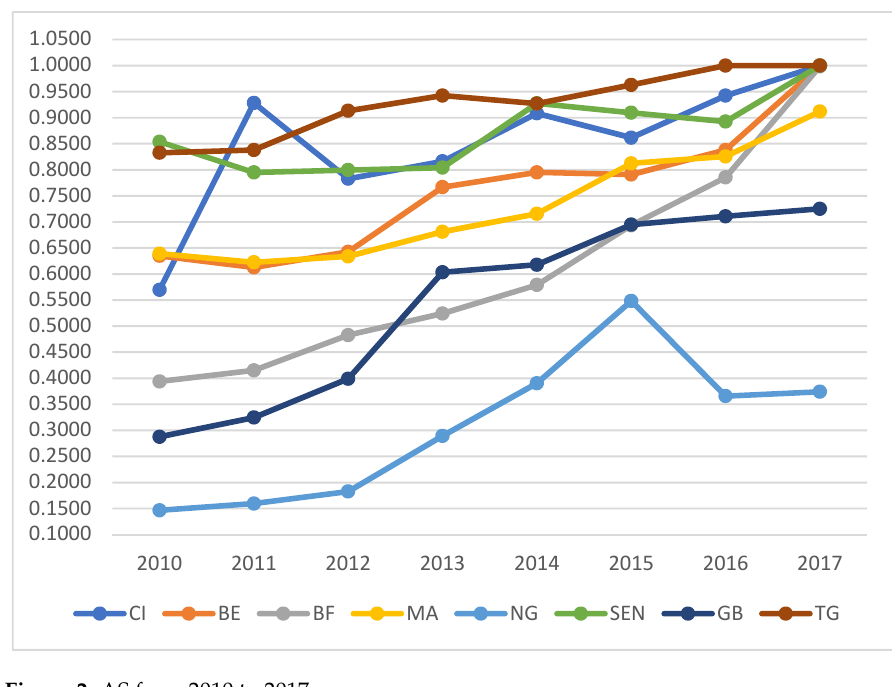
Figure 2. AS from 2010 to 2017.